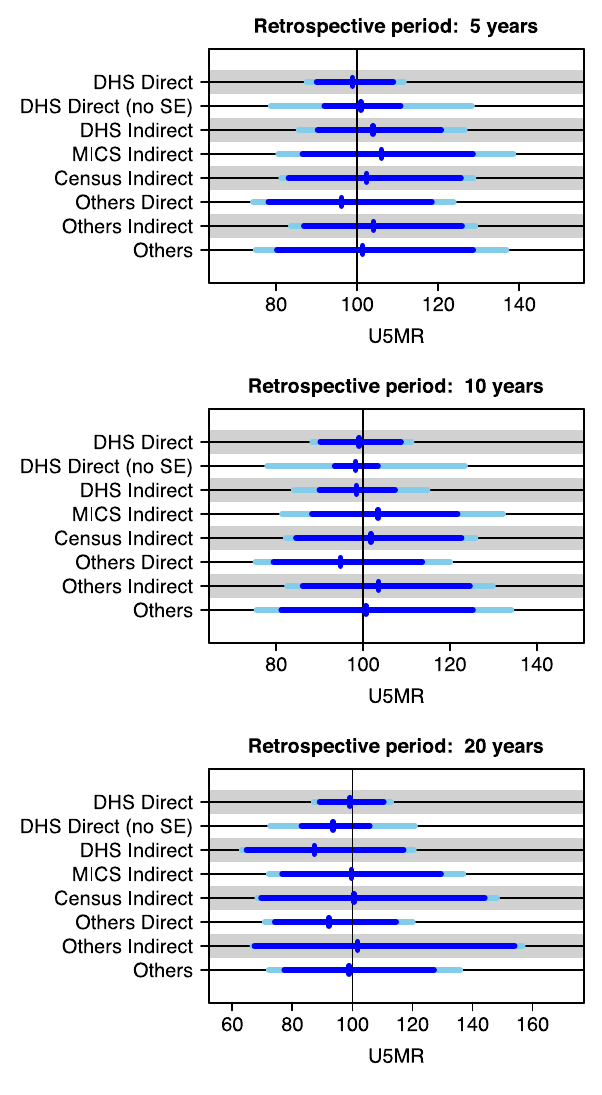
Figure 2. Visualization of 90% prediction intervals for new data points by source type and retrospective period. For a ‘‘true’’ U5MR of 100 deaths per 1,000 live births (represented by the black line), the 90% prediction interval for a U5MR observation is shown in light blue (for DHS direct series, this excludes the sampling variability), and the predicted mean observed U5MR is represented by the blue vertical line (the difference between the mean U5MR and 100 represents the mean bias). The blue horizontal line represents the 90% prediction interval for an observation based on uncertainty in the bias parameters only (excluding sampling and non-sampling variability). SE, sampling error.